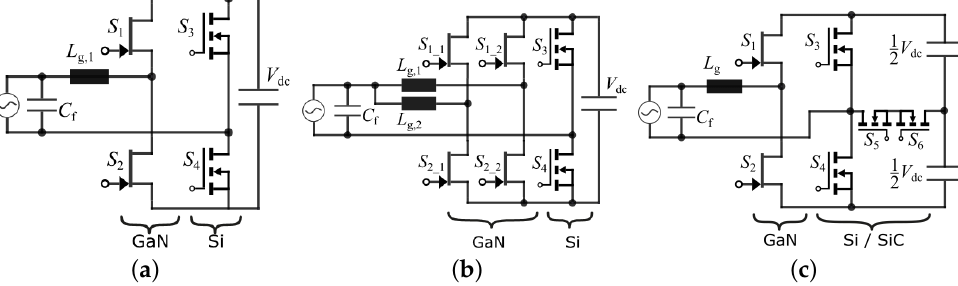
Figure 16. ( a ) GaN-based totem-pole PFC rectifier, ( b ) interleaved GaN-based totem-pole PFC